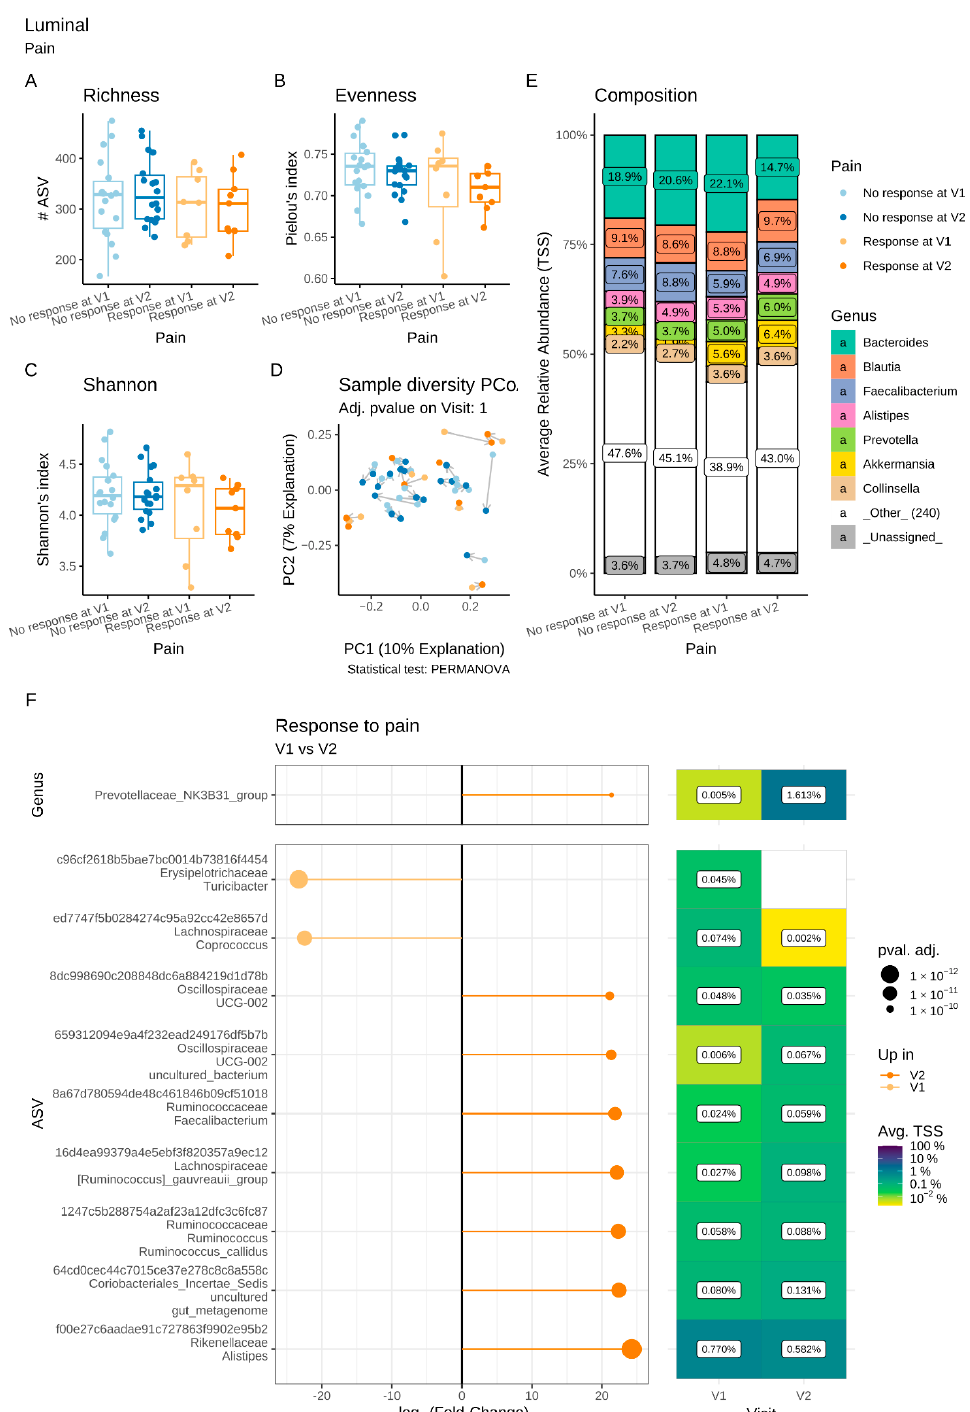
Figure 5. Impact of a 4-week supplementation with the multistrain probiotic on the luminal gut microbiota in Pain responders (R) and non-responders (NR). A-C: α -diversity estimated by the richness (number of observed ASVs) ( A ), evenness (Pielou’s index) ( B ) and Shannon’s index ( C ) at V1 and V2; ( D ) Principal coordinate analysis (PCoA) of bacterial β -diversity measured according to the Bray-Curtis distance; ( E ) Bacterial taxonomic profile at genus level prior (V1) and after supplementa- tion (V2); ( F ) Differential abundance analysis at the genus and ASV levels at V1 and V2 in Pain R. Only significant data are presented as Log2 of the fold of change (FC) according to DESeq2 analysis. Transcription start sites (TSS)